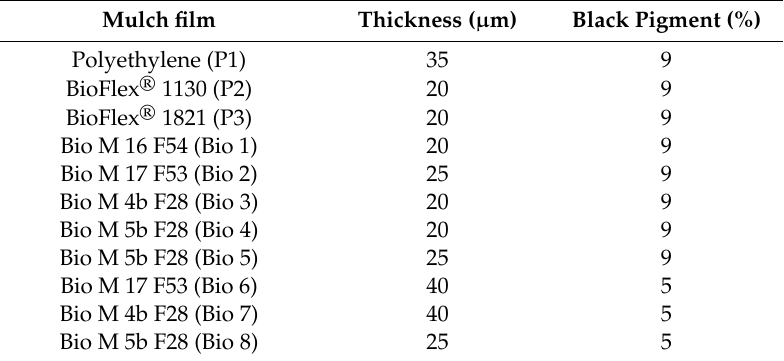
Table 1. Mulch film types, thickness and black pigment